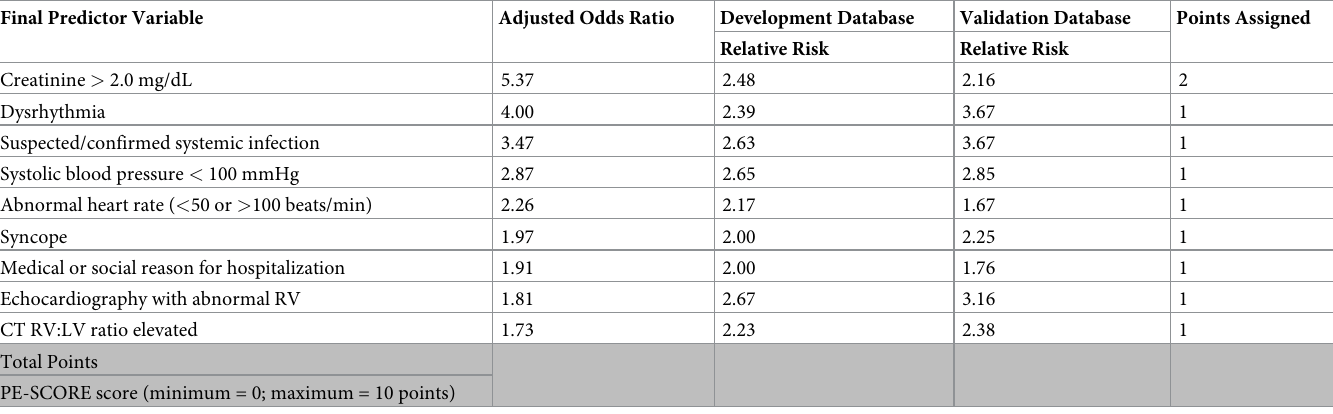
Table 3. Primary outcome probability for final model